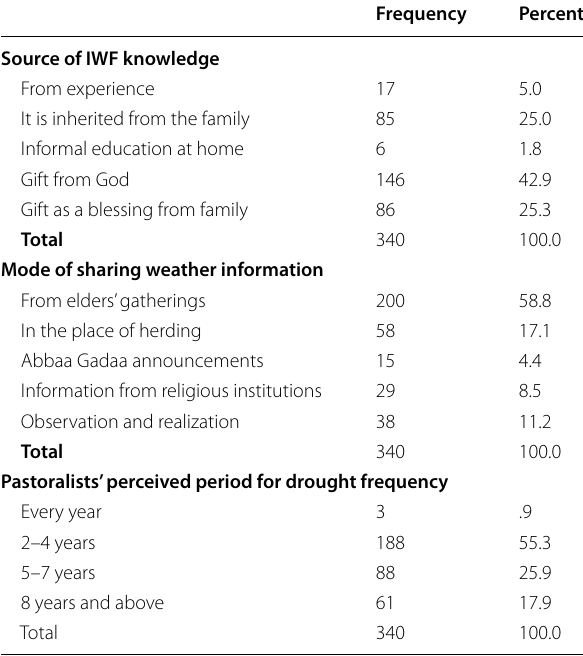
Table 1 Acquisition of IWF and mode of sharing